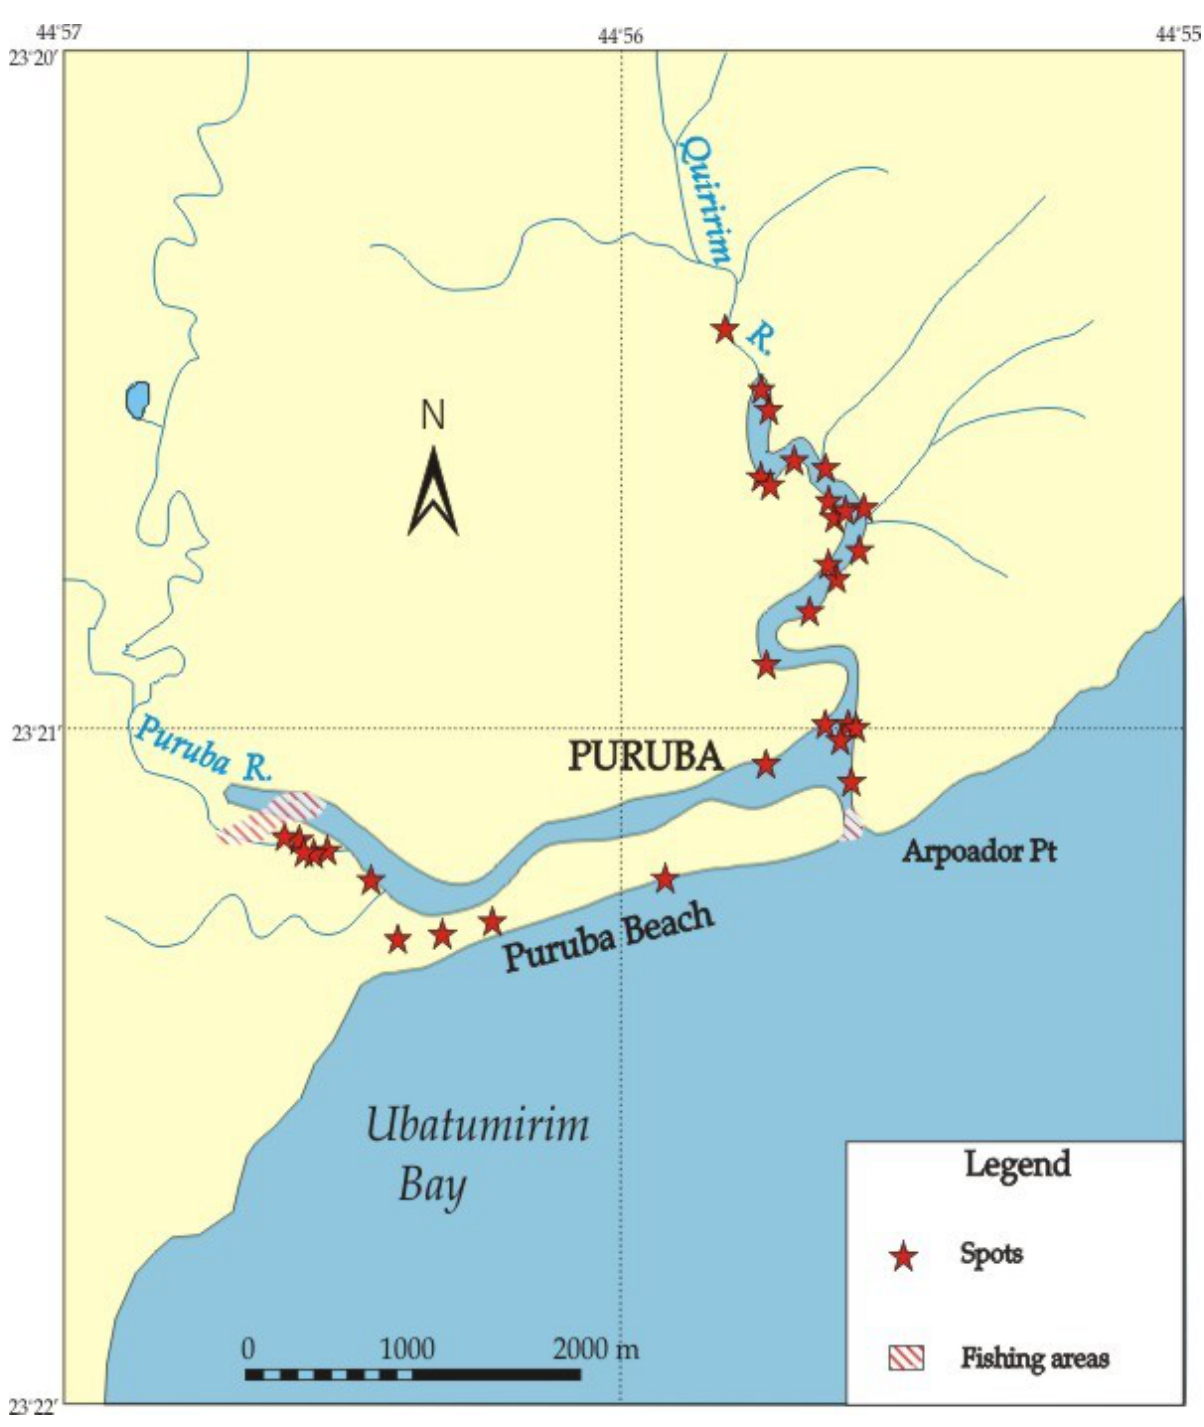
Fig. 5 . Fishing spots marked at Puruba Beach, Ubatuba, São Paulo State, in